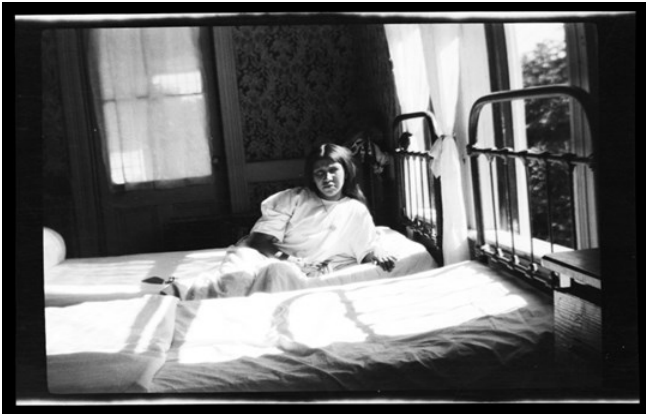
Figure 17. Lucy Sumpty, Inside the Girls’ Dormitory—Phoenix Indian Boarding School, c. 1915. Parker McKenzie Collection. Courtesy of the Oklahoma Historical